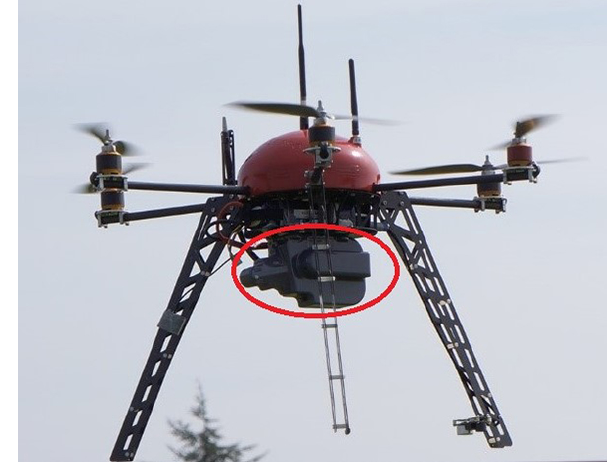
Figure 2. LOAC on board an unmanned aerial vehicle of the Fly N Sense Company; LOAC is on the black box at the bottom of the vehicle (red circle).